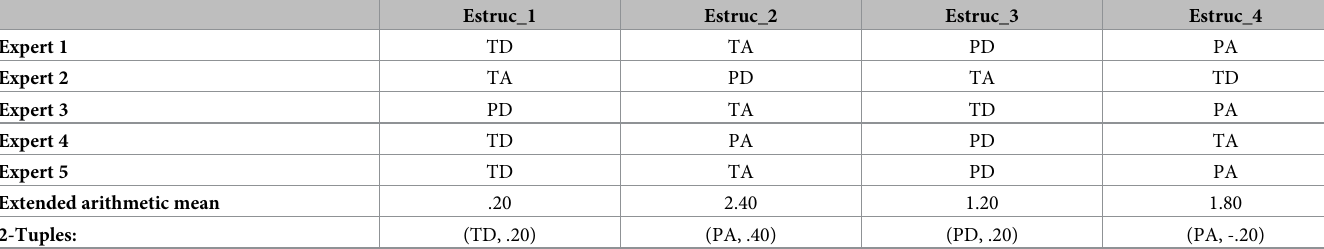
Table 4. Evaluations of linguistic preference provided by experts in 4 alternative structures to define the partition cores.